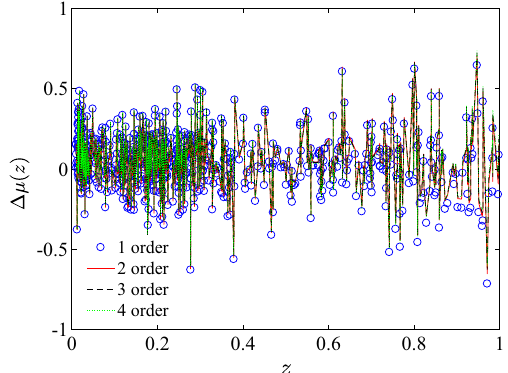
Fig. 3 Residuals between the cosmographic distance modulus with different orders and the observational SNIa data. The vertical coordi- nates (cid:4)μ( z ) = μ cos ( z ) − μ obs ( z ) denotes the